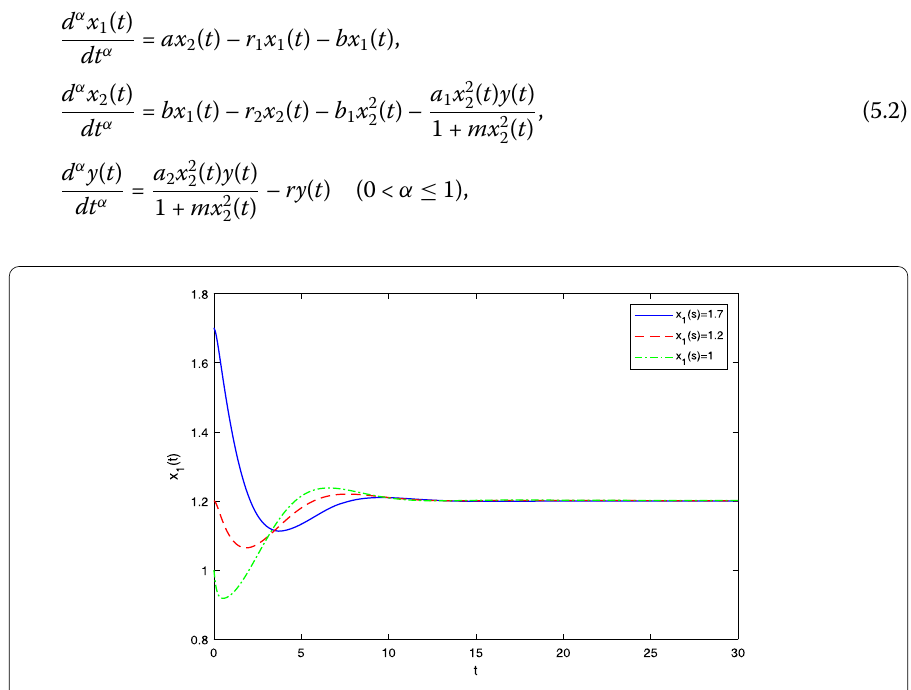
Figure 1 Time responses of state variable x 1 ( t ) with α =